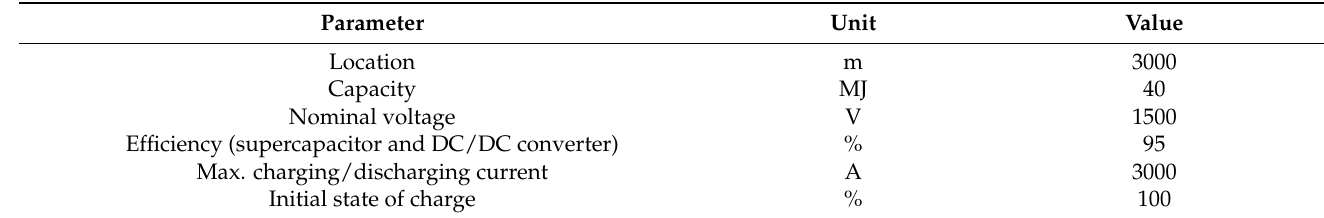
Table 9. TPH with WESD input parameters.